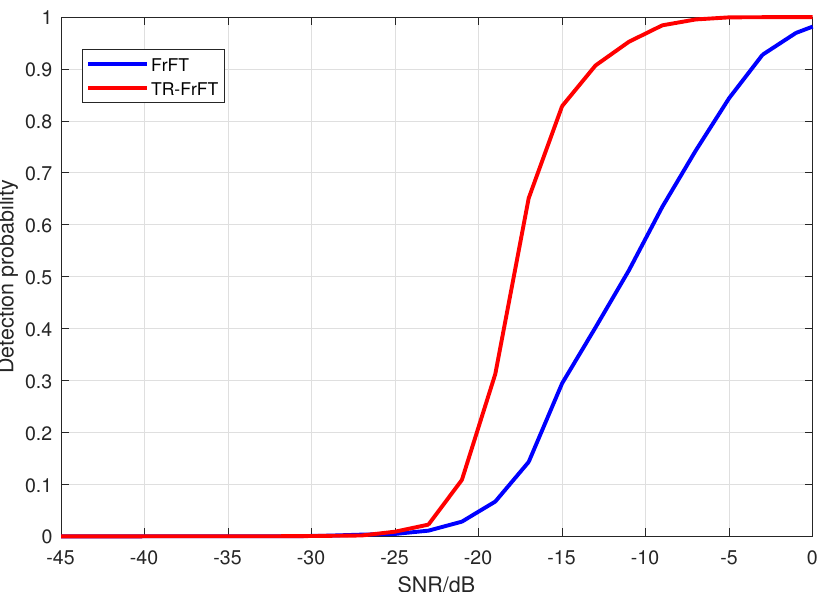
Figure 17. Detection probability vs. SNR. The false alarm rate is P F =